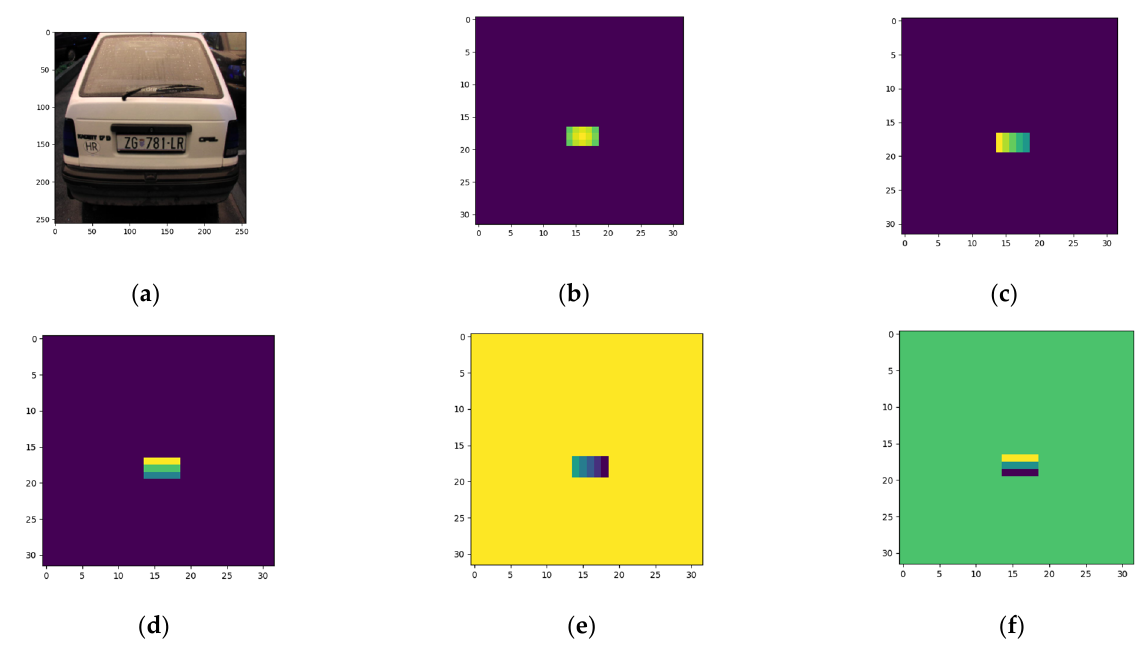
Figure 6. License plate encoding: ( a ) original image is converted to 256 × 256 image; ( b ) object center point is encoded using Gaussian distribution; ( c ) distances from the current pixel center point to the object’s upper left x point; ( d ) distances matrix from the object’s current pixel point to the object’s upper left y point; ( e ) distances from the current point of the center point to the lower left x point of the object; ( f ) distances matrix from the current pixel center point to the lower left y point of the object.